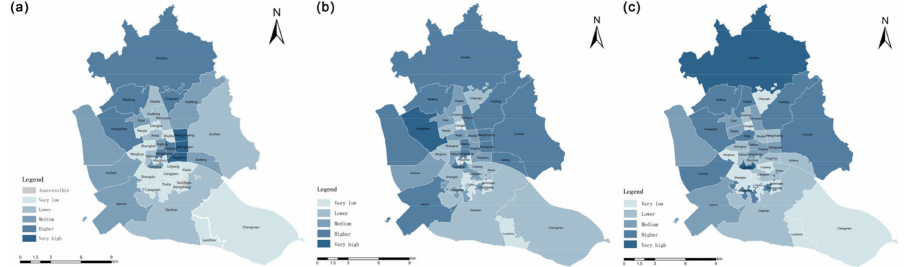
Figure 5. G2SFCA-based sub-district scale accessibility under different traveling scopes ( a ) 5-min life circle. ( b ) 15-min life circle. ( c ) 30-min life